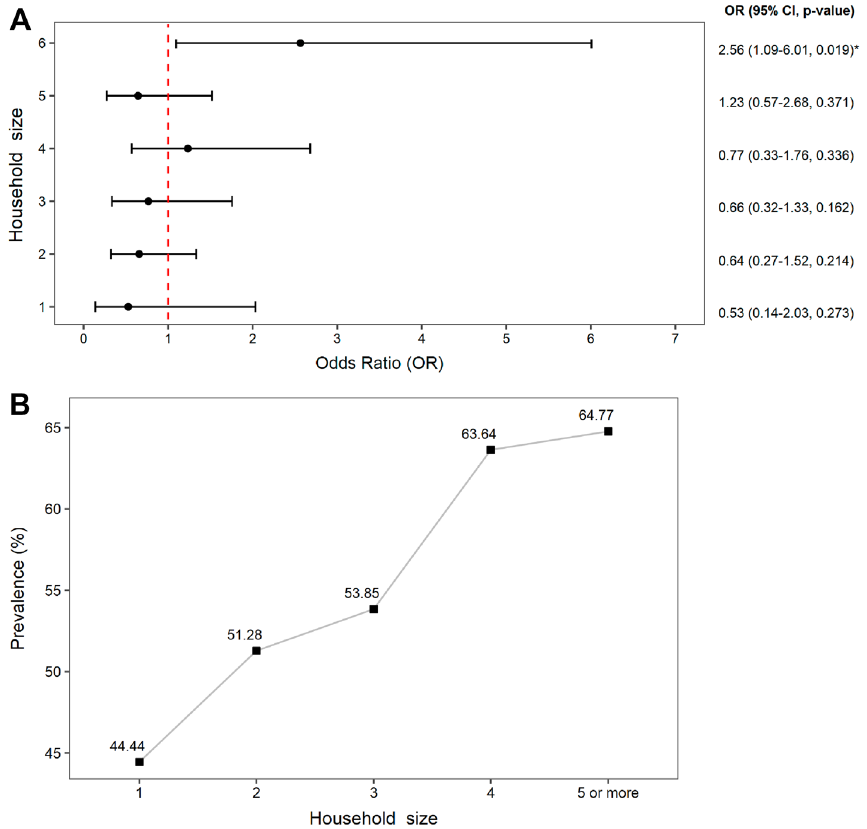
Figure 4. Prevalence rates by household size. ( A ) Association between the risk of exposure to infection and the household size (number of members). ( B ) SARS-CoV-2 prevalence rates according to the number of inviduals per resindence. OR Fisher’s exact test (*p <